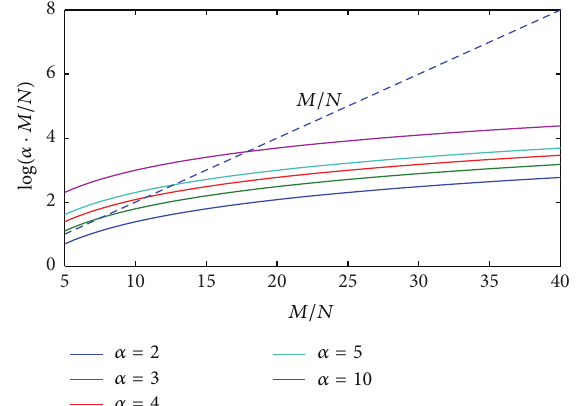
Figure 3: Behavior of (18) for the case 𝑁 = 5 , 𝛼 = 2, 3, 4, 5, 10 : ratio 𝑀/𝑁 is required to be between 18 and 20.